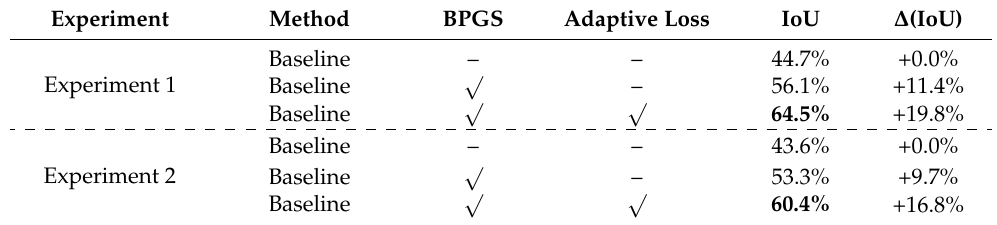
√ Table 3. The results of the ablation study. and — separately represent used and not used; the entries in bold denote the best results in the corresponding experiment; and ∆ (IoU) is the IoU change compared with the